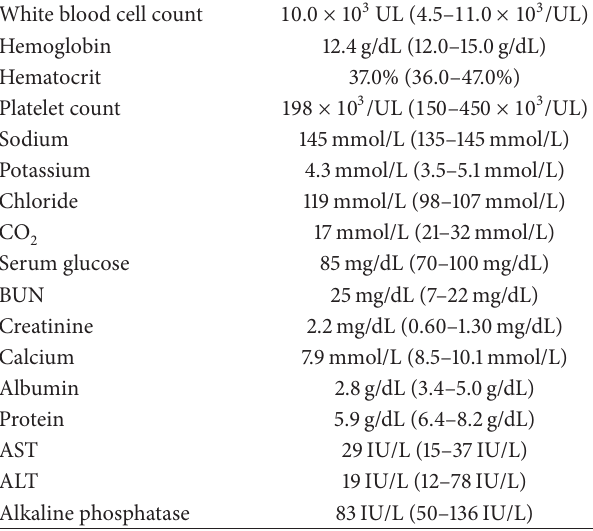
Figure 1: Chest CT: residual 6 cm thin walled cyst in the posterior aspect of the left midlung field (green arrows). Table 1: Initial laboratory